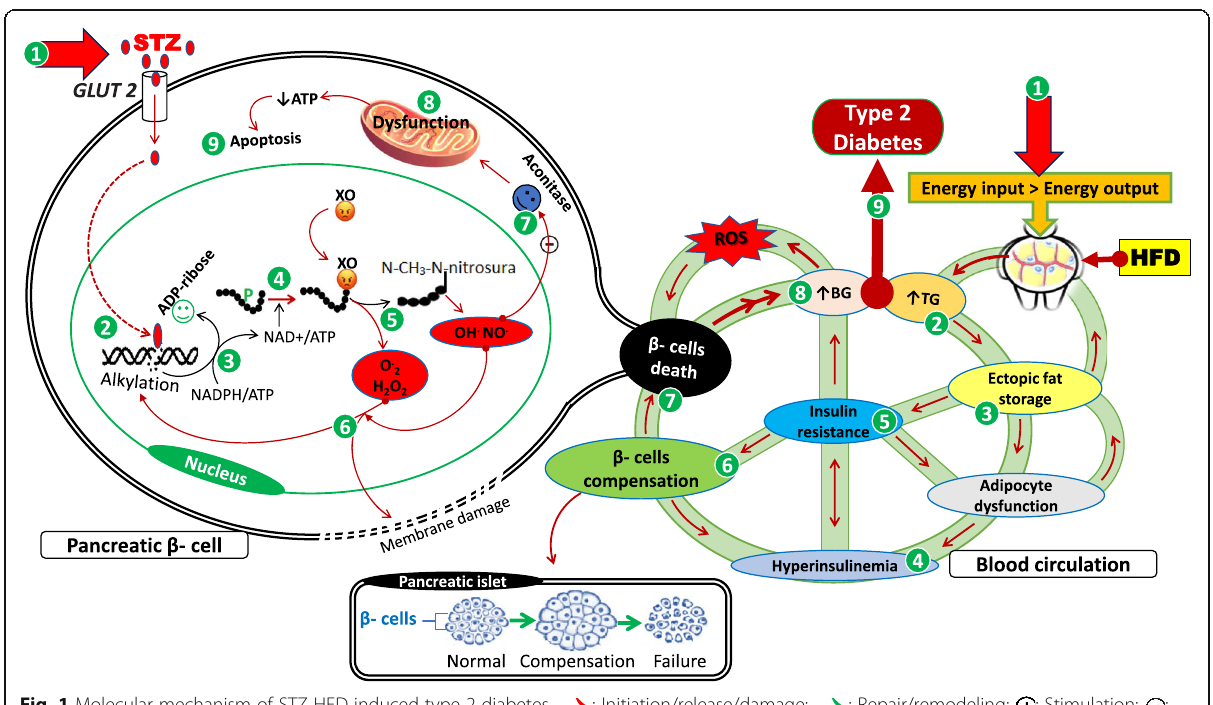
Fig. 1 Molecular mechanism of STZ-HFD induced type 2